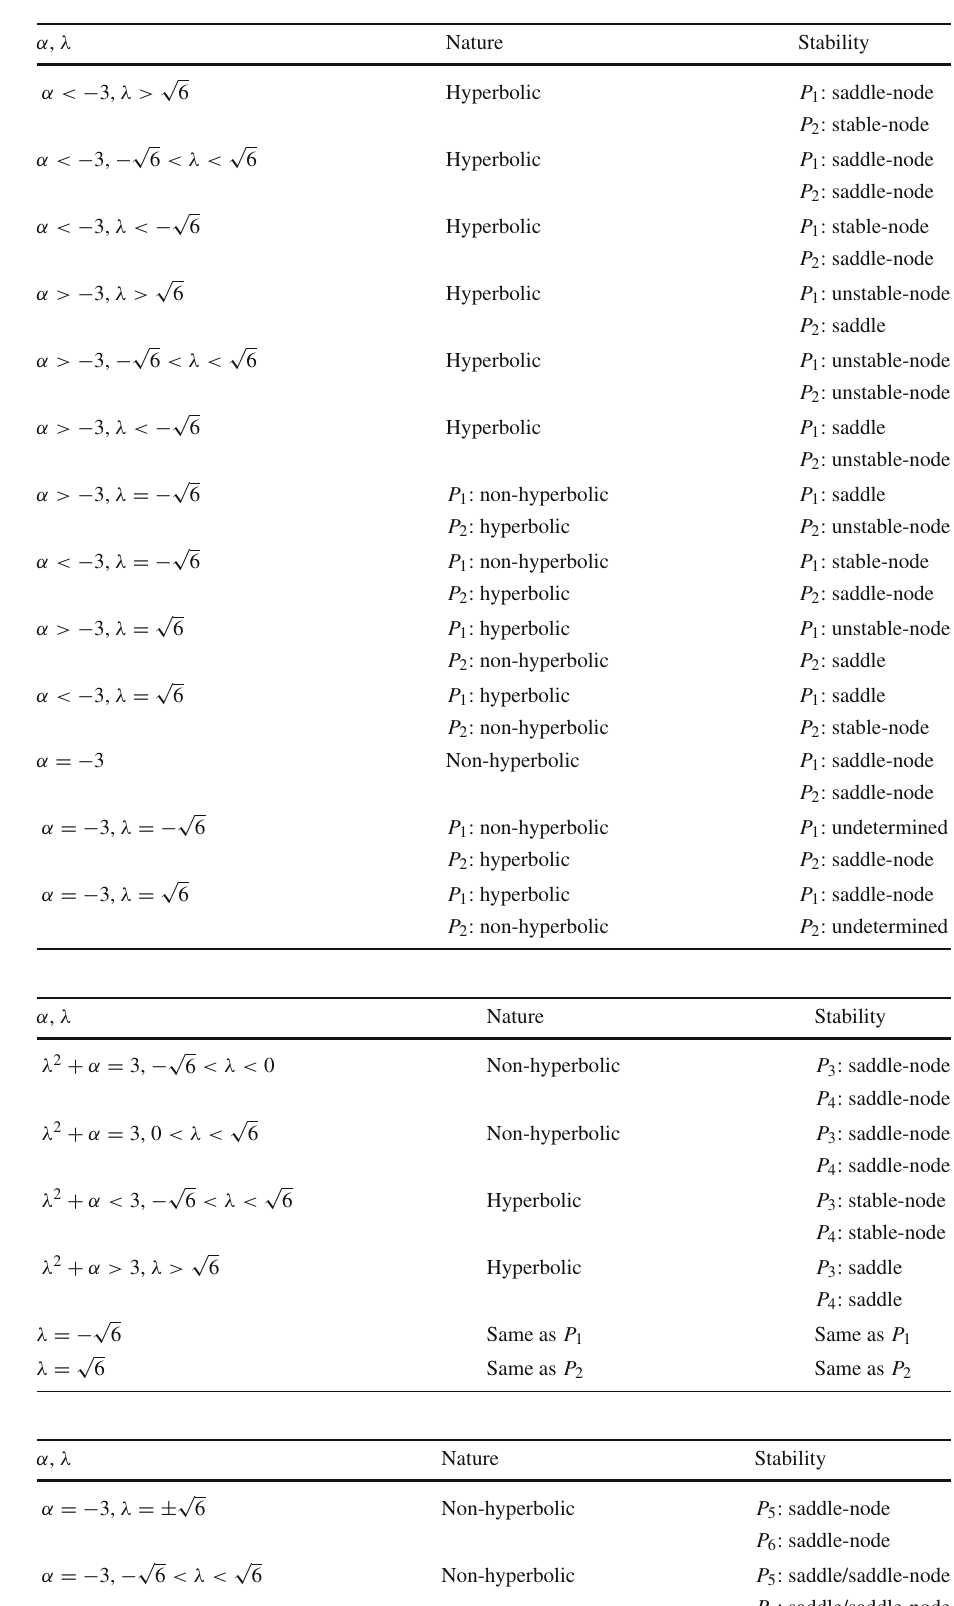
Table 6 Stability of P 1 and P 2 according to range of parameters